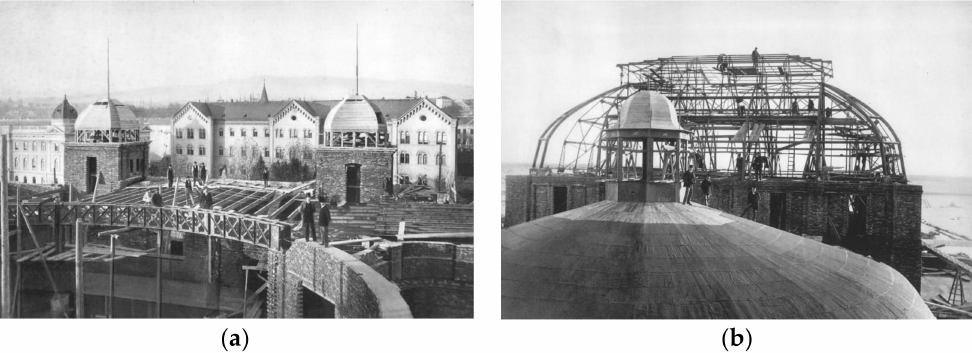
Figure 1. ( a , b ) Views of the National Theater of Zagreb during its construction. Provision courtesy from Hrvatsko Narodno Katalište u Zagrebu.